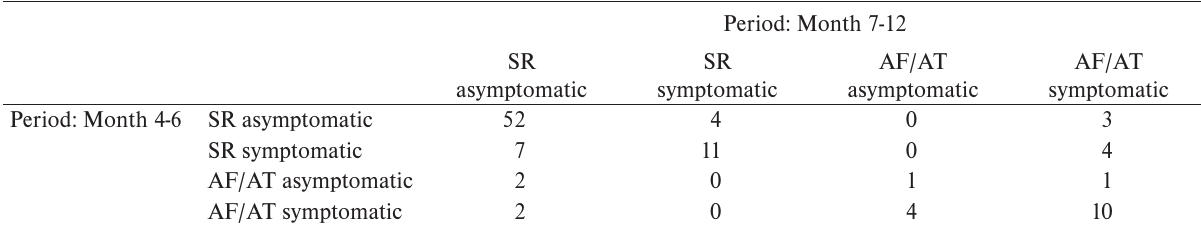
Table 3. Arrhythmia satus by monitoring period.